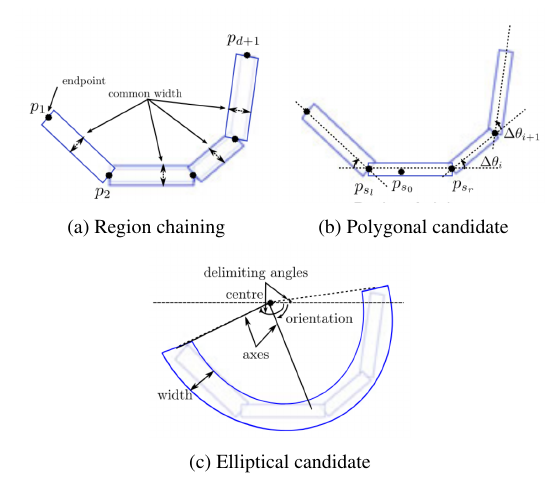
Figure 8. ELSDc polygonal line and elliptical arc candidates. (Figure reprinted from (P˘atr˘aucean et al.,